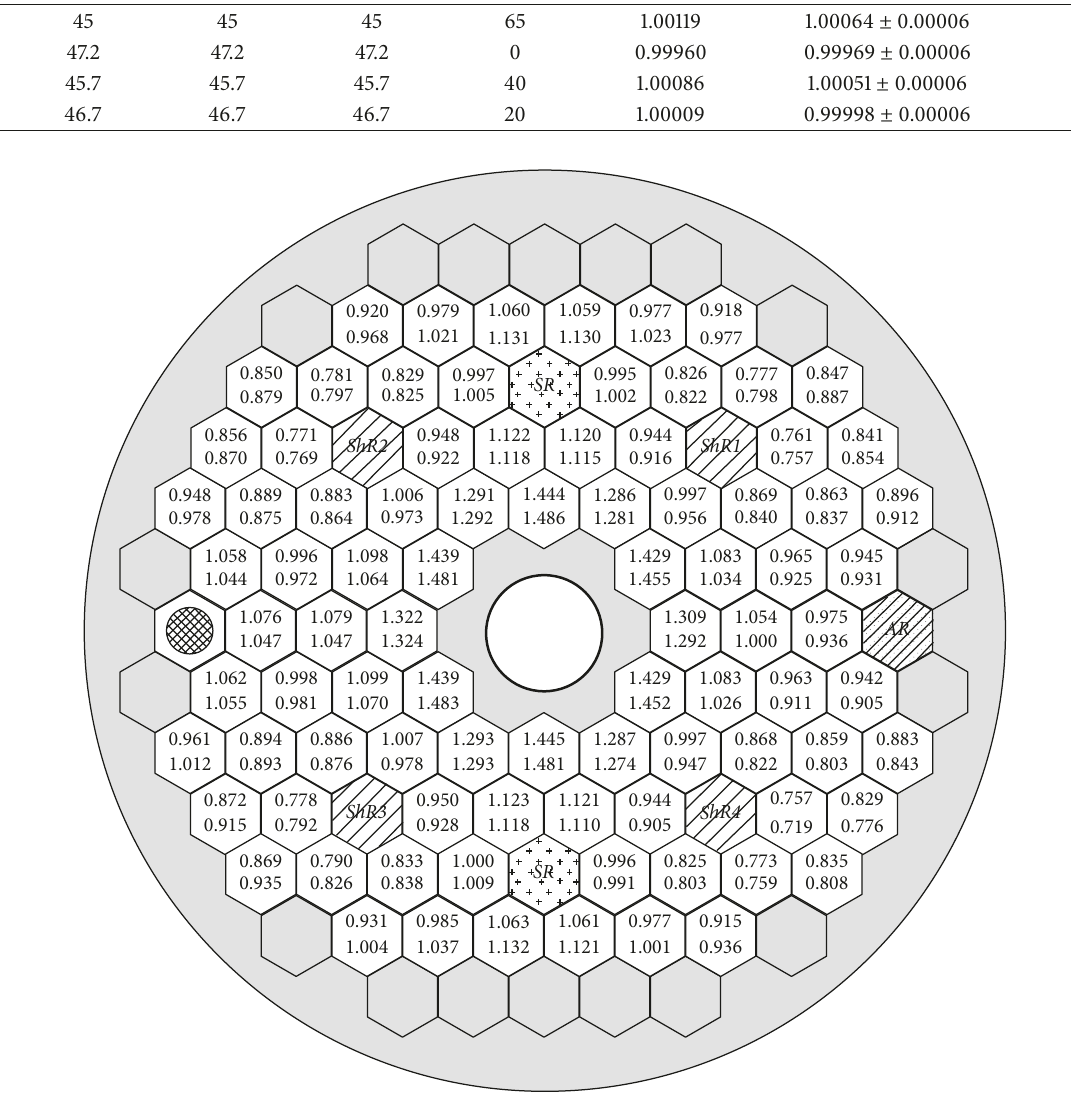
Figure 6: Relative power distribution in the core at the initial critical condition corresponding to the control rod insertion: ShR = 45.7 cm; AR = 40 cm. The upper and lower values were obtained with SRAC and MCNP5,